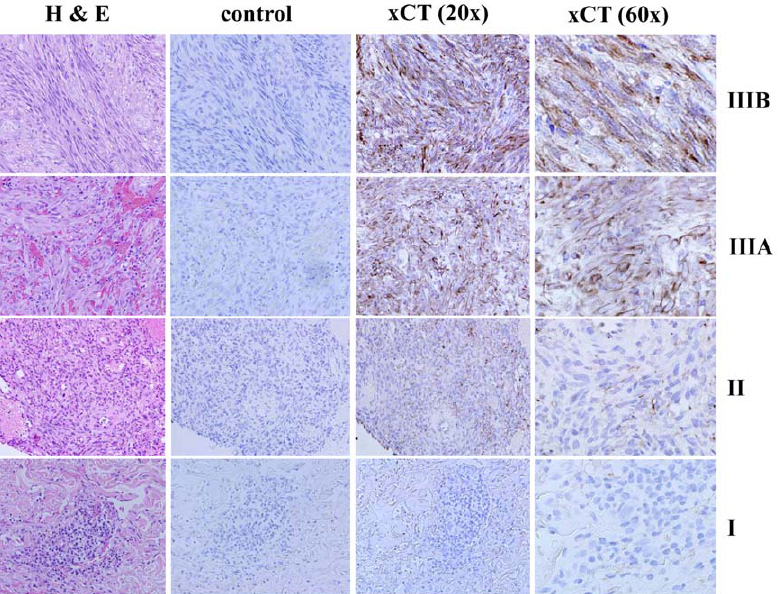
Figure 9. xCT expression within KS lesions correlates with tumor stage. KS diagnosis and histopathologic staging were independently confirmed by a dermatopathologist using hematoxylin and eosin (H & E). Tumors were then processed for immunohistochemistry as described in Methods using either pre-immune sera (control) or xCT anti-sera. xCT expression is revealed by dark brown membrane-associated staining in contrast to blue nuclear staining. Representative images from all stages (I=patch, II=plaque, III=nodule) are shown, including two different stage III tumors (A and B). All images are shown at original magnification 6 20 or 60.